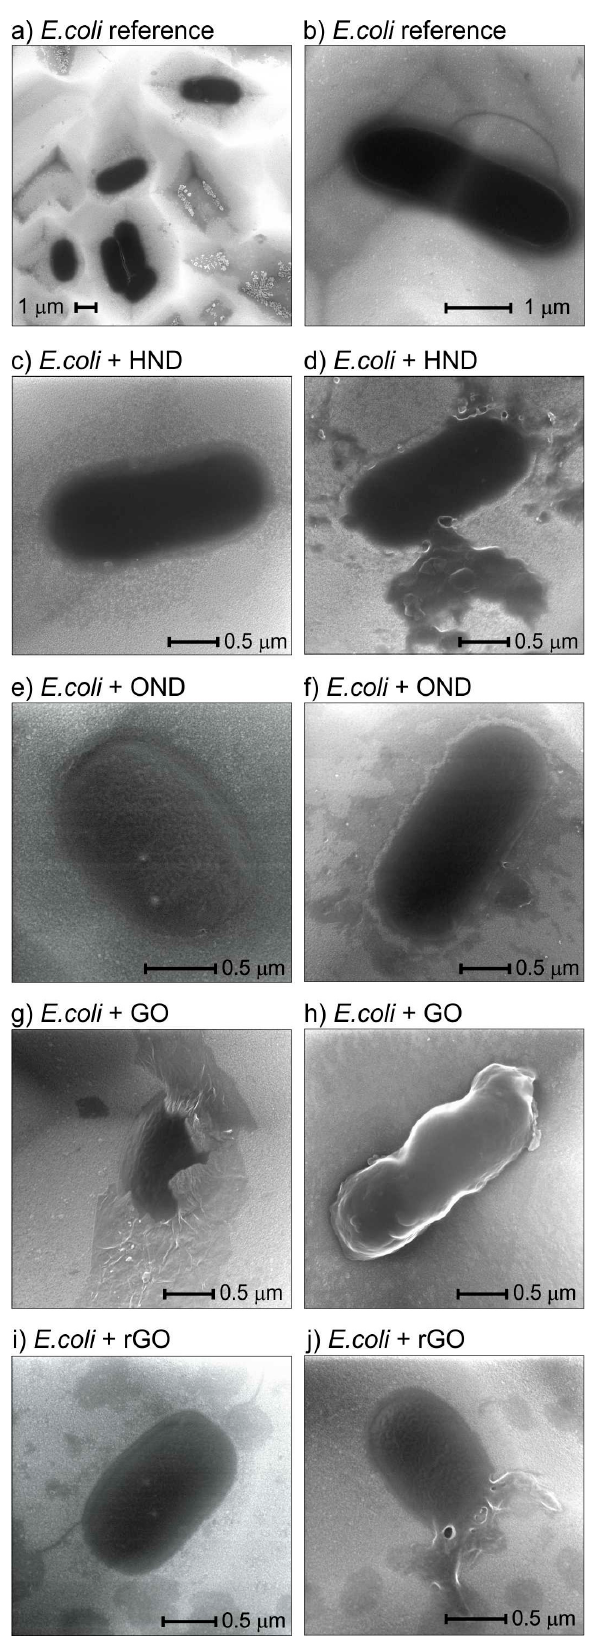
Figure 5. Typical SEM morphologies of E. coli sampled on silicon substrates from the reference suspension ( a , b ) and from suspensions where E. coli was exposed to HND ( c , d ), OND ( e , f ), GO ( g , h ), rGO ( i , j ). Set of two images for each material illustrates various morphologies of the